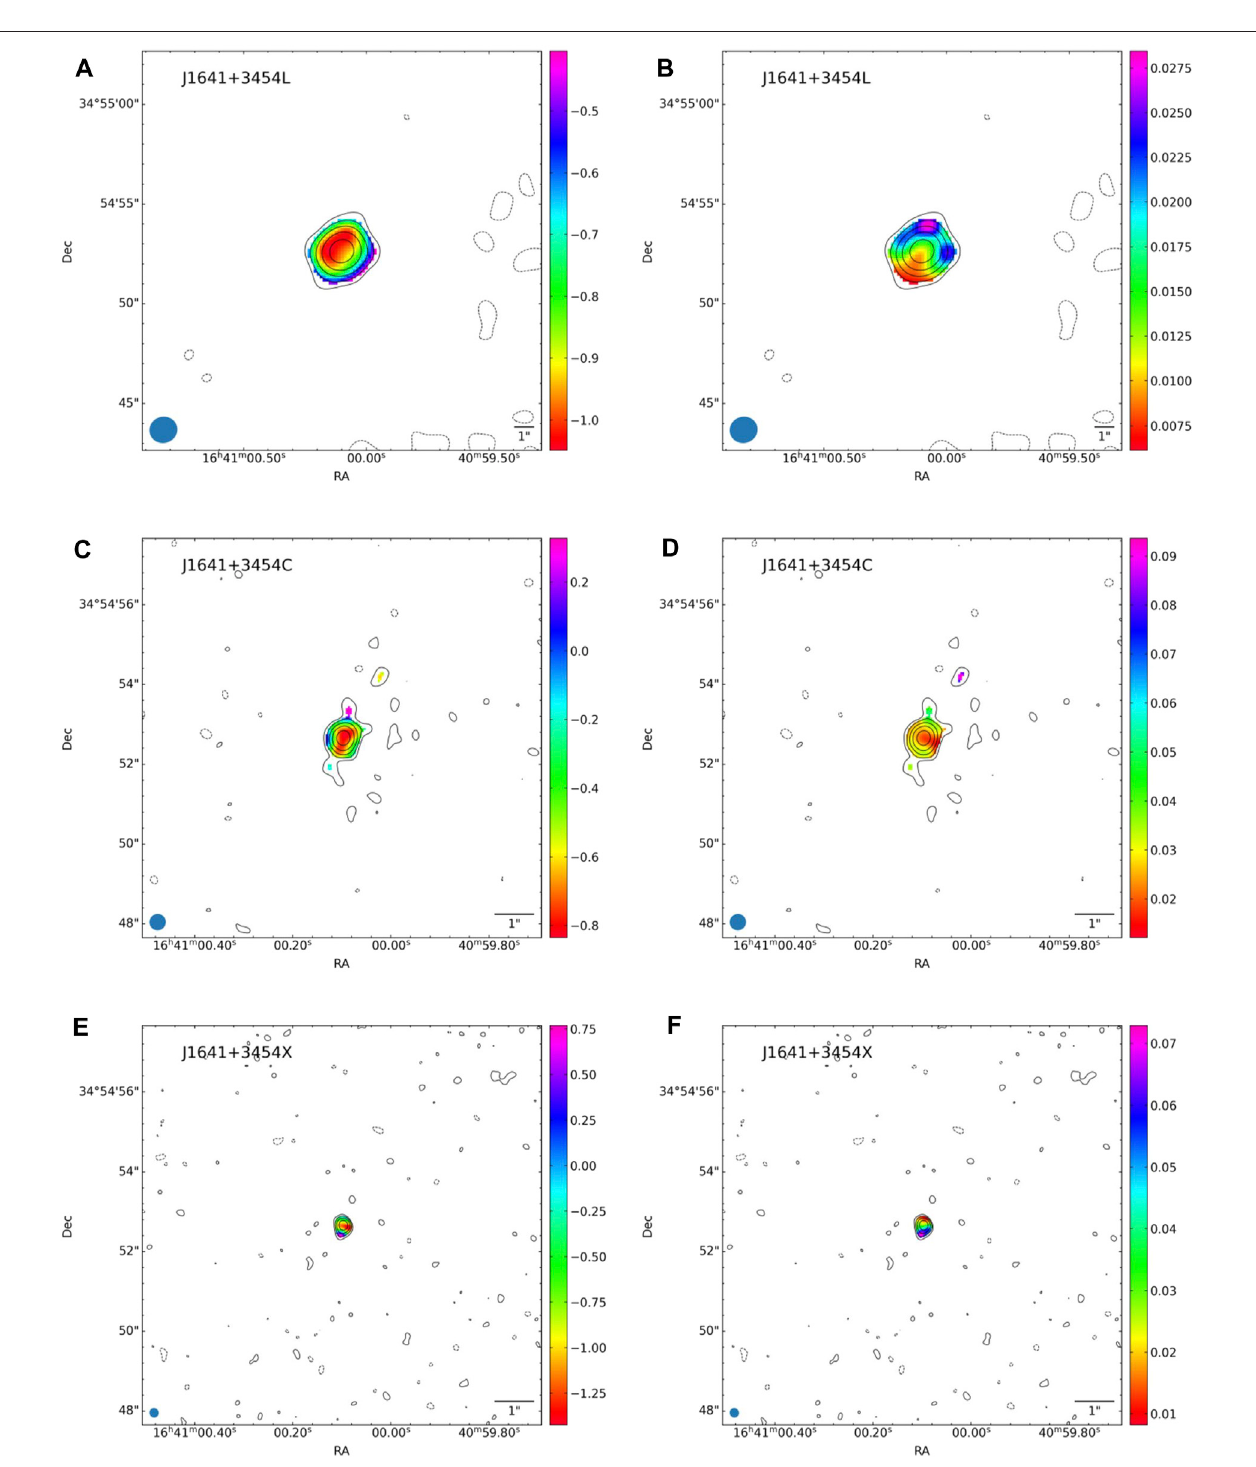
FIGURE5|(A) 1.6 GHz α map,rms (cid:1) 25 µ Jybeam − 1 ,beamsize4.96 × 4.64 kpc; (B) 1.6 GHz Δ α map;(C)5.2 GHz α map,rms (cid:1) 7 µ Jybeam − 1 ,beamsize1.48 × 1.44 kpc; (D) 5.2 GHz Δ α map; (E) 9.0 GHz α map,rms (cid:1) 7 µ Jybeam − 1 ,beamsize0.84 × 0.81 kpc (F) 9.0 GHz Δ α map.Contourlevelsat − 3,3 × 2 n , n ∈ [0,4]in (A – D) , and n ∈ [0, 3] in (E) and (F) . The scale is 3.518 kpc/arcsec.